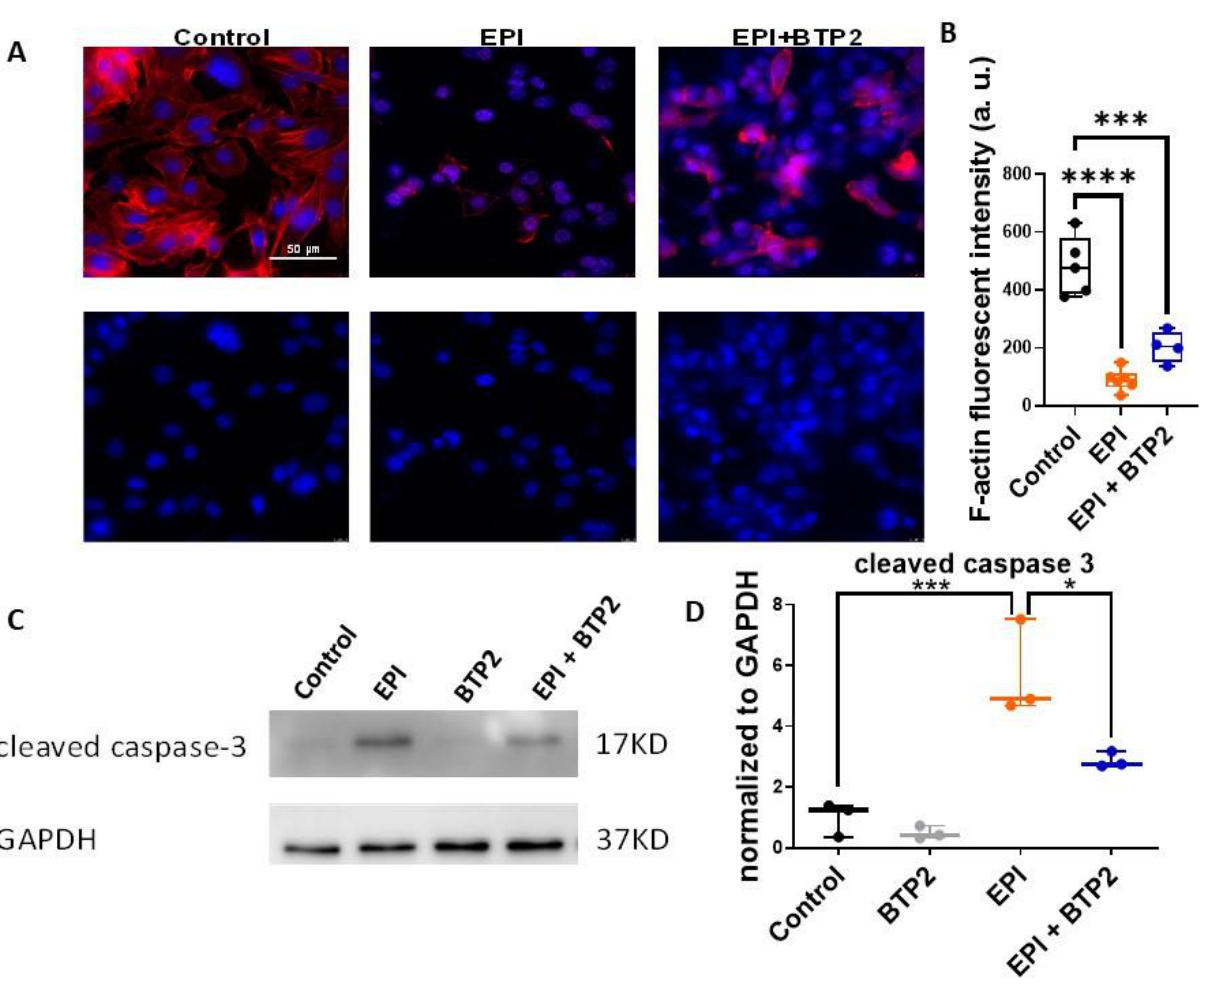
Figure 4. BTP2 inhibited EPI-induced apoptosis in HL-1 cardiomyocytes. ( A ) Cell nuclei were stained with DAPI (blue) and F-actin was stained with phalloidin (red). F-actin degradation was observed with 1 µM EPI treatment for 5 h. With 20 µM BTP2 co-treatment, the EPI-induced F-actin disruption was partially rescued. ( B ) The F-actin fluorescence intensity was quantified. ***: p < 0.001; ****: p < 0.0001 ( C ) Western blotting analysis of cleaved caspase 3 expression in HL-1 cardiomyocytes. Cells were treated by vehicle (control), 1 µM EPI, 20 µM BTP2, or 1 µM EPI plus 20 µM BTP2 for 5 h followed by normal culture conditions for 24 h. GAPDH was used as loading control. ( D ) The quantification of cleaved caspase 3 normalized to the expression of GAPDH. Three independent biological replicates were carried out and used for the quantification. ***: EPI vs. Control, p = 0.0009; *: EPI + BTP2 vs. EPI, p = 0.0218 (based on one-way ANOVA and Bonferroni post hoc analysis).